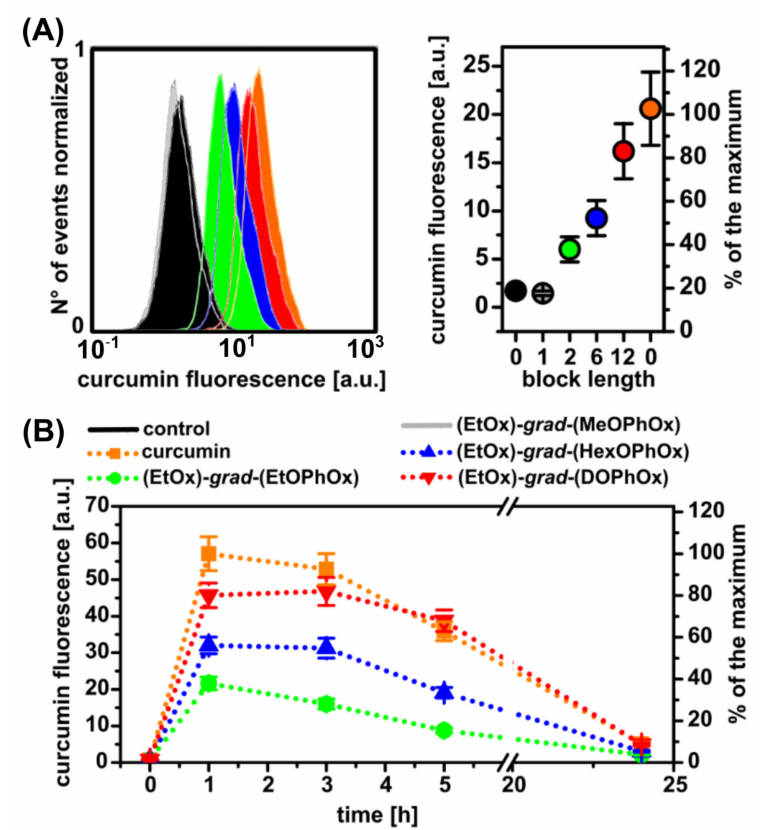
Figure 4. Uptake of curcumin and curcumin-loaded polymeric NPs by U87 MG cells detected by flow cytometry. ( A ) Flow cytometric histograms detected 1 h after sample administration (left) and maximum of curcumin fluorescence intensities detected (right). Color code is similar as denoted in image ( B ), which represents fluorescence of curcumin detected 0, 1, 3, 5, and 24 h after